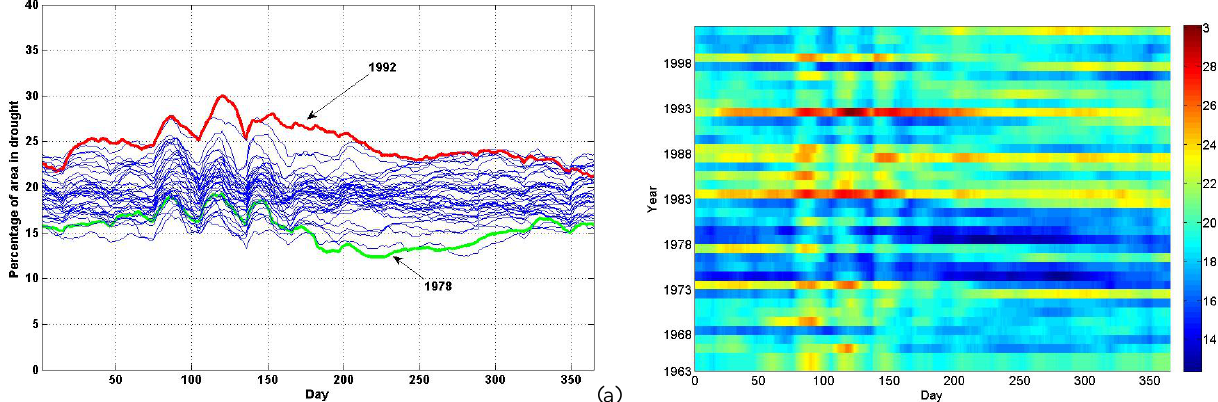
Fig. 7. Results of the NCDA analysis over the globe for the period 1963–2001. (a) Time series of area in drought (percentage of the globe) and (b) color-coded table of area in drought (as percentage of the globe area).